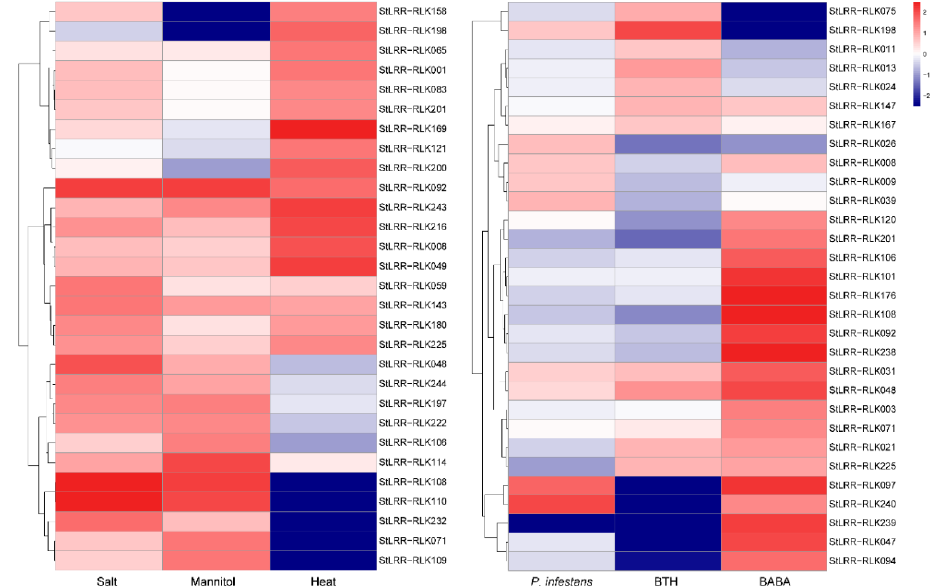
Figure 6. Heat map representation and hierarchical clustering of selected StLRR-RLK genes under abiotic and biotic stresses. The relative expression ratios of biotic and abiotic stress treatments were calculated relative to their controls respectively, and then up-regulated genes were defined to have a log 2 relative expression ratio ≥ 1 under certain stress treatments. The bars of heat map represent the log 2 relative expression ratio. The red color, white color, and blue color represent the up-regulated, unaltered, and down-regulated expression respectively.